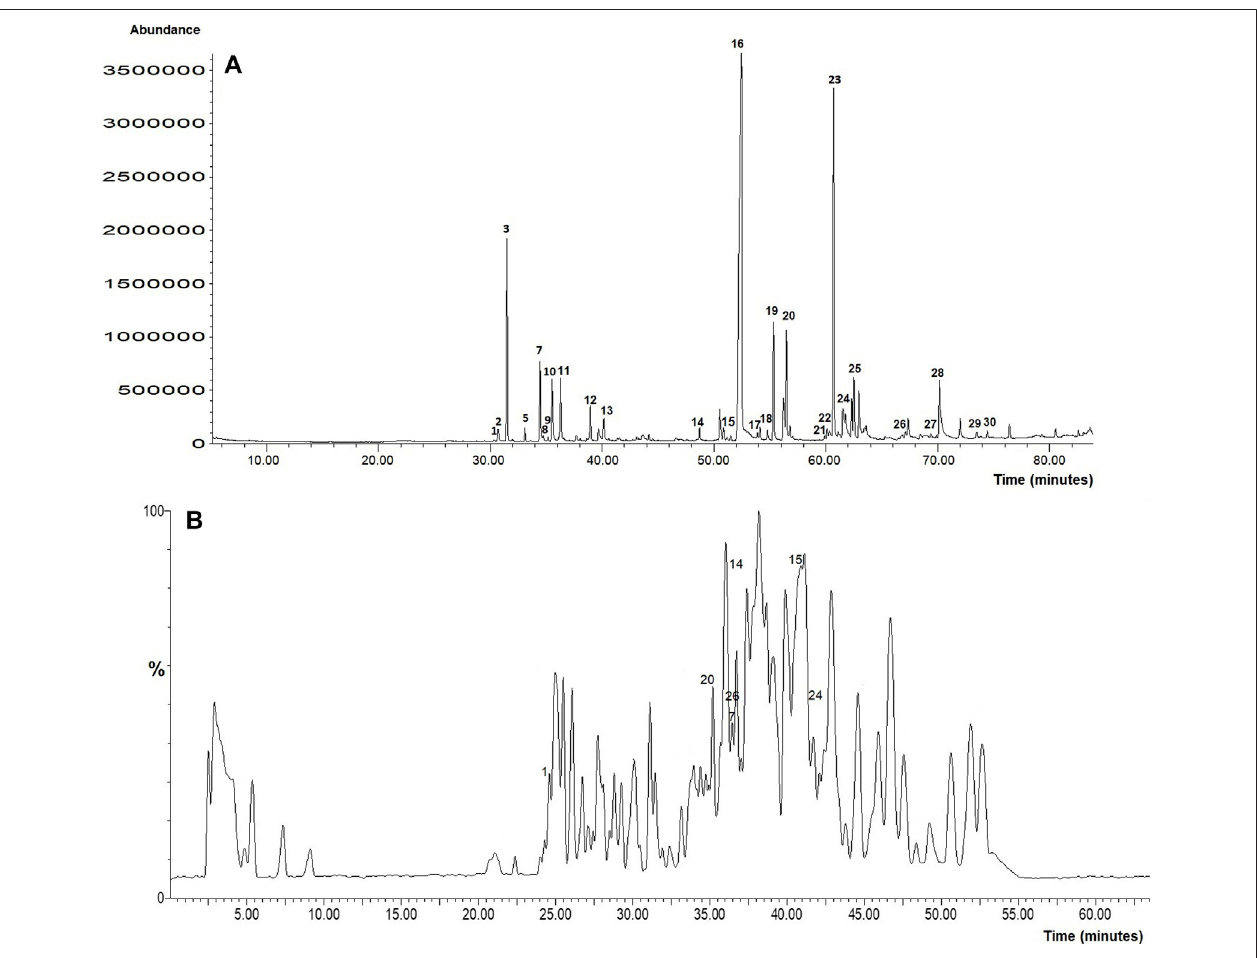
FIGURE 10 | (A) GCMS and (B) LCTOFMS total ion chromatograms of compounds from Ba E. Known compounds were labeled according to Supplementary TableS1 and SupplementaryTableS2 .Eachnumberlabeledatchromatogramreferredtothenumberin SupplementaryTableS1 and SupplementaryTableS2 .